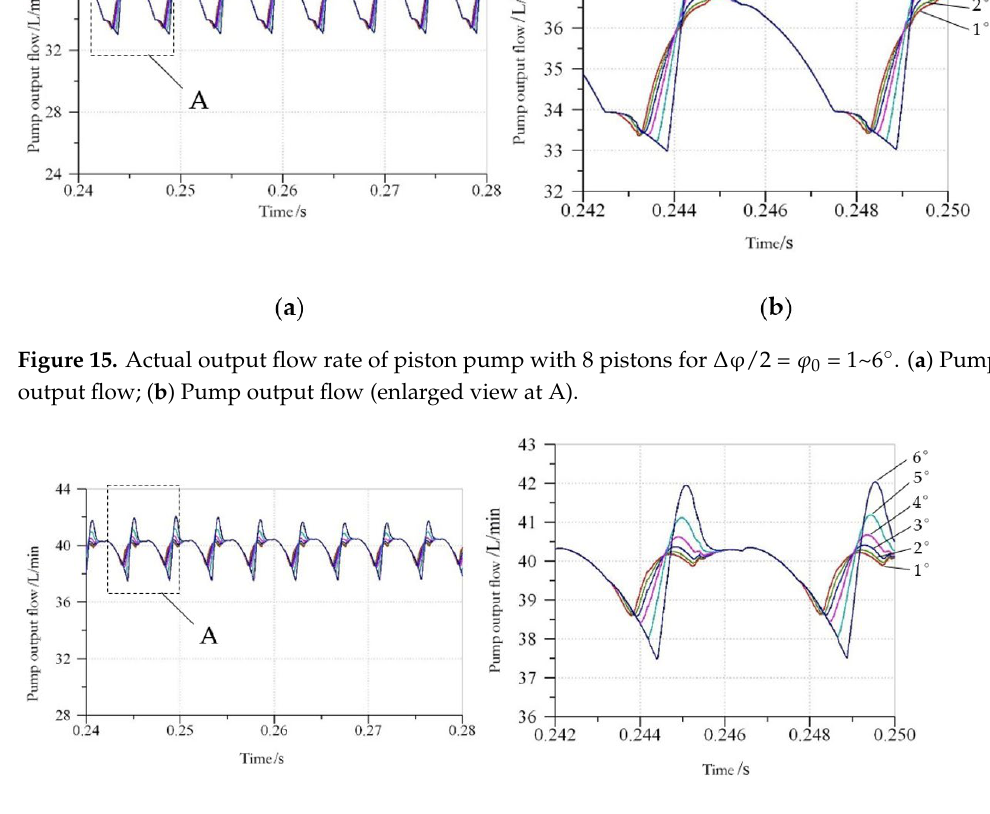
Figure 16. Actual output flow rate of piston pump with 9 pistons for ∆ ϕ /2 = ϕ 0 = 1~6 ◦ . ( a ) Pump output flow; ( b ) Pump output flow (enlarged view at A).